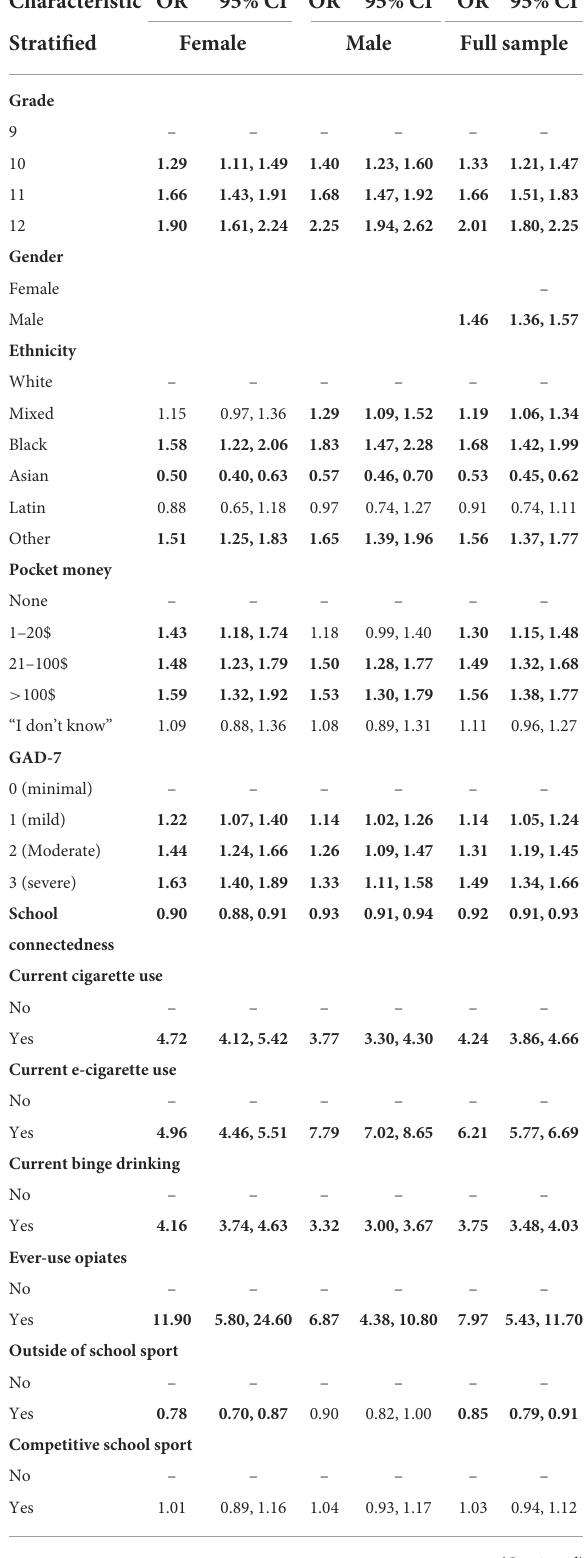
not associated with current cannabis use. See Table 4 for full model